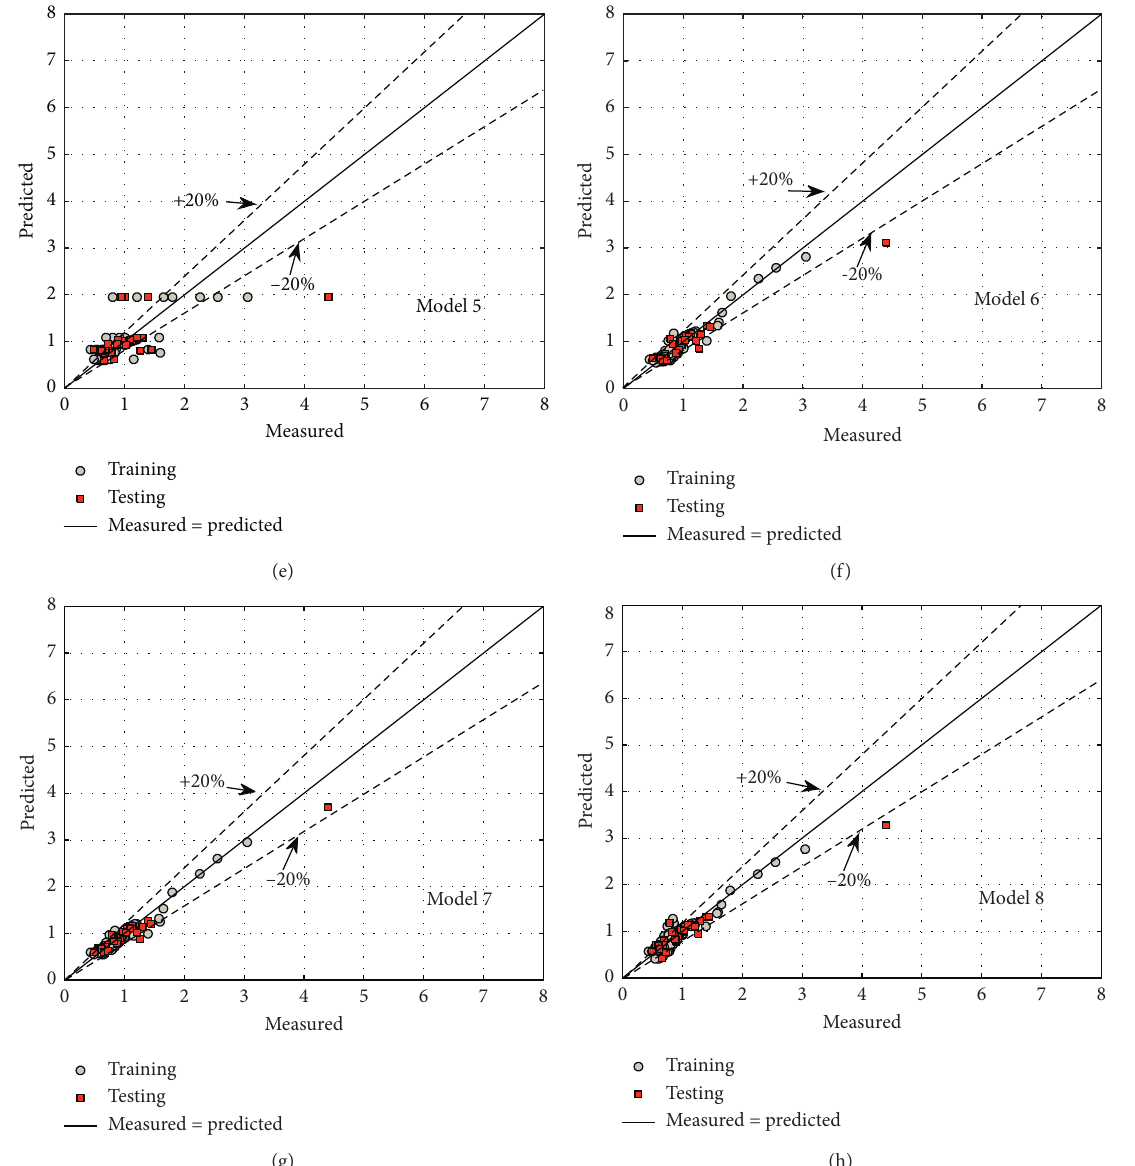
Figure 2: Measured versus predicted void ratio of tailings using GEP models. (a) Model 1. (b) Model 2. (c) Model 3. (d) Model 4. (e) Model 5. (f) Model 6. (g) Model 7. (h) Model